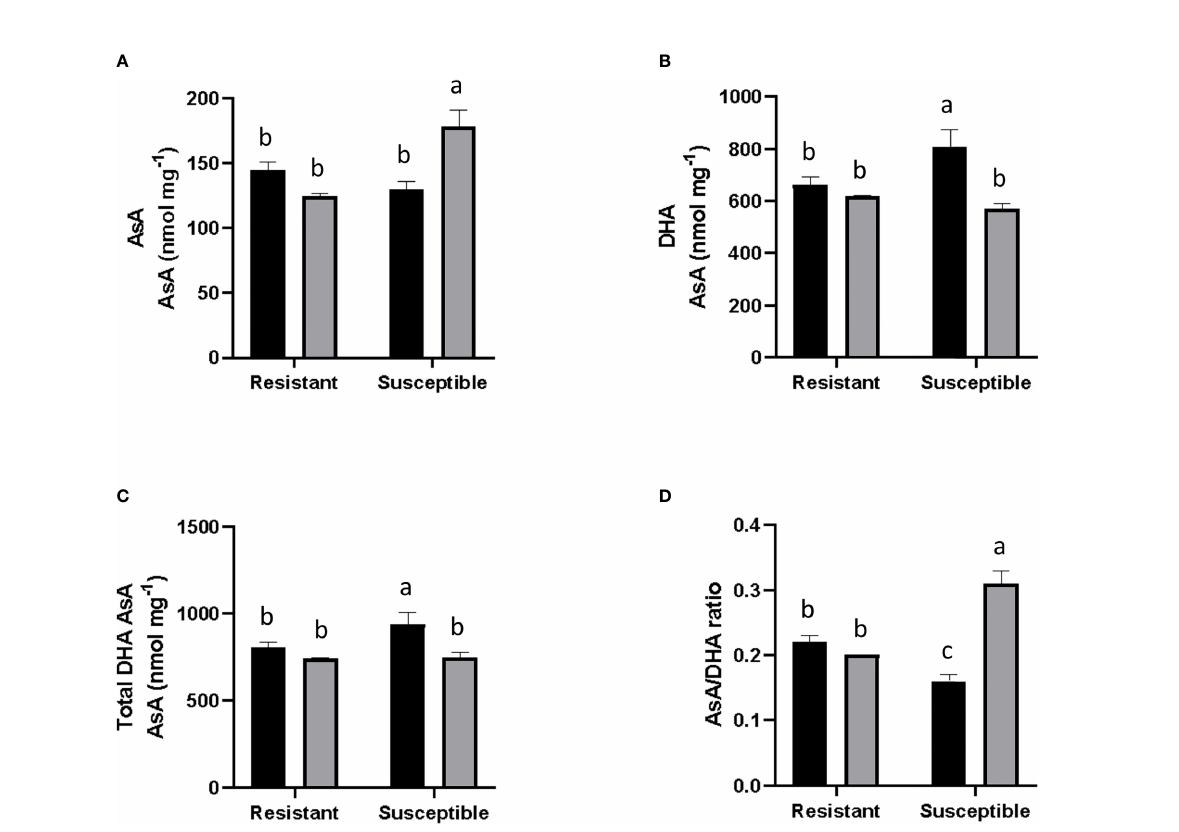
FIGURE 4 Evaluation of Ascorbic Acid content and associated parameters. Gray and black bars correspond to E . necator inoculated and non-inoculated plants. (A) Ascorbic Acid (AsA) levels; (B) Dehydroascorbic Acid (DHA); (C) Total AsA and DHA levels; and (D) Asa/DHA ratio. Black bars represent non inoculated plants, and grey bars indicate E . necator inoculated plants. Lowercase letters indicate statistically signi fi cant differences among inoculated and non-inoculated in factors interaction (genotypes*infection condition). A two-way ANOVA and the Tukey multiple comparison post hoc test ( p ≤ 0.05) (n=3 ± SD) were